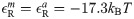
Fold-change and occupation for the looping scenarios.(A) Fold-change as a function of the fugacity λR for the looping scenario (blue curve, Eq (17)) and the exclusive looping scenario (green curve, Eq (20)). The pink curve is the simple repression scenario. (B) Average occupation of repressors to a single gene 〈Rads〉/N in Eq (22) in the looping architecture. (C) Fold-change as a function of the total number of repressor molecules R for the looping scenario (blue curve) and exclusive looping (green curve) scenario. (D) the repressor fugacity as function of the total number of repressor molecules R for both the looping and exclusive looping scenario. The value of ϵRm=ϵRa=-17.3kBT, and FL = +10kBT as in [34]. Furthermore, we took the number of promoters to be N = 10 and the number of non-specific sites to be Nns = 5 × 106.